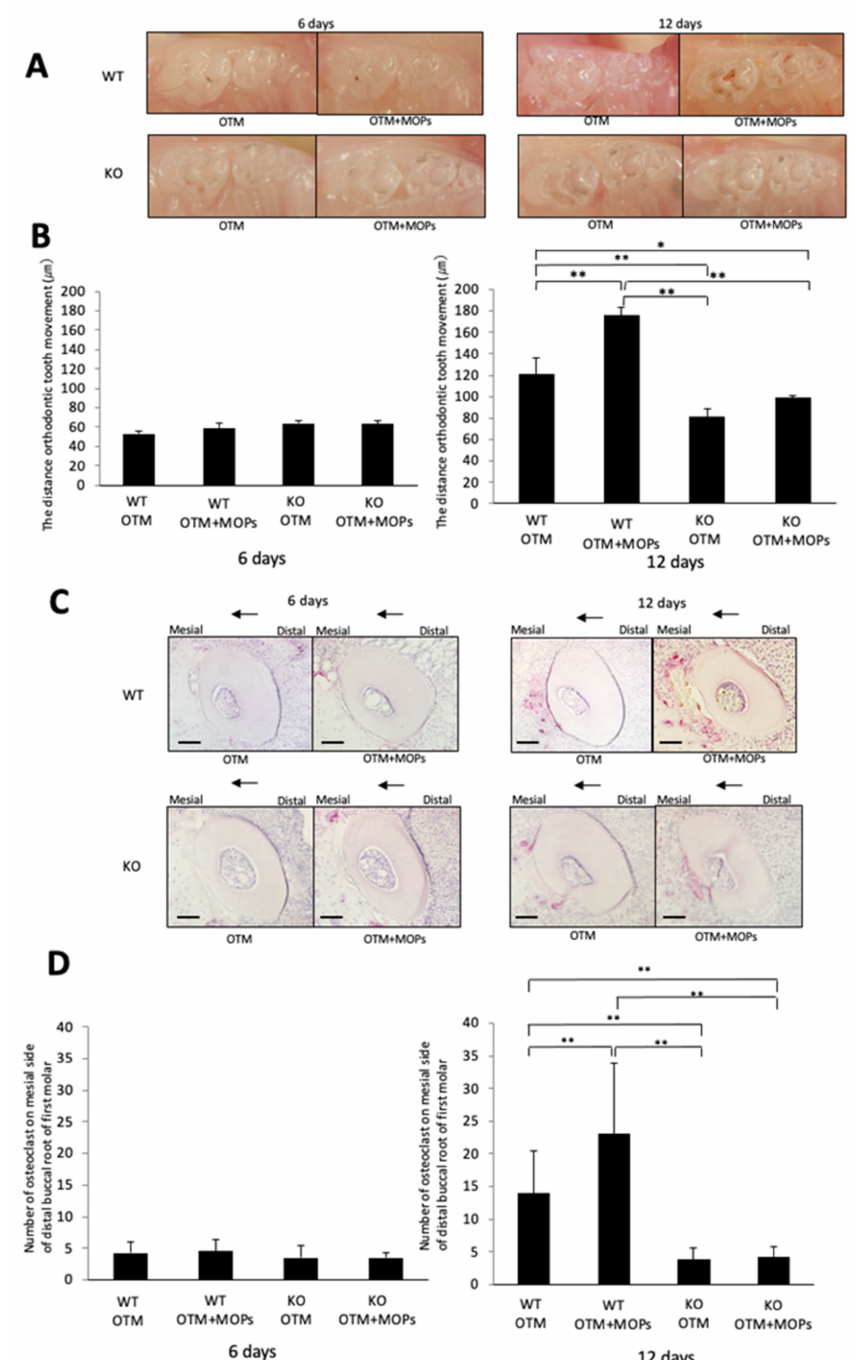
Figure 4. MOPs-induced tooth movement and osteoclast formation is dependent on TNF- α : ( A ) Images of teeth after 6 and 12 days of OTM in WT and KO mice with and without MOPs. ( B ) Measured distance of tooth movement in WT and KO mice with and without MOPs after 6 and 12 days of experimental loading. ( C ) TRAP-stained histological sections of the distobuccal root of the maxillary left first molar in WT and KO mice with and without MOPs after 6 and 12 days of experimental loading. ( D ) The TRAP-positive osteoclast cell number at the alveolar bone surface around the distobuccal root of the left maxillary first molar after 6 and 12 days of OTM for WT and KO mice with and without MOPs. The results are given as the mean ± standard deviation ( n = 4). ** p < 0.01 and * p < 0.05 indicate significant differences, which were analyzed by using the Scheffe test. Scale bars = 100 µ